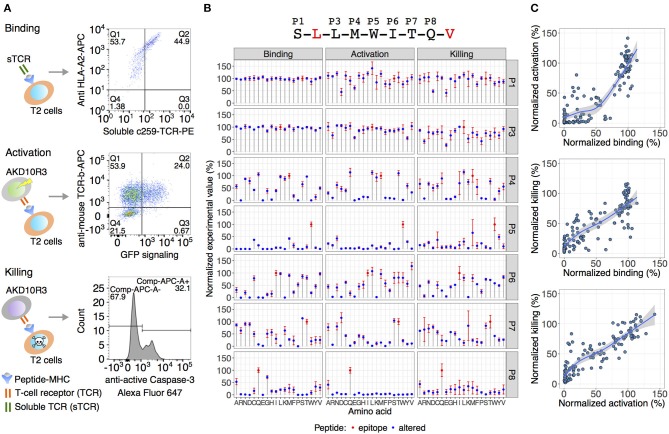
Experimental validation of TCR NY-ESOc259 specificity. (A) An overview of the assays used for TCR specificity assessment analyzing binding of the TCR to the peptide-MHC complex on antigen-presenting T2 cells, activation of TCR-expressing cells by co-culturing with T2 cells and final killing of the target T2 cells. (B) The effect of amino acid substitution in the epitope peptide (displayed at the top of the figure) on TCR binding/activation/killing. Blue dots depict the average signal of at least two independent experimental replicates (binding n = 3, activation n = 3, killing n = 2). The error bars show standard error of the mean (SEM). An observed TCR NY-ESOc259 specificity pattern is similar across all three assays. Positions five (P5) and eight (P8) are crucial for TCR sensing of the peptide, and to a lesser extent, positions P4, P6, and P7. (C) Pairwise comparisons of the normalized experimental values among the three assays. Activation and killing assays yielded a strong linear relationship (R2 = 0.8, p < 2e-16) indicating a strong dependence between T cell activation level and killing efficiency. Comparing binding with activation and killing assays resulted in a less linear relationship, and in many cases at least 75% binding efficiency is required to trigger T cell activation and killing mechanisms.